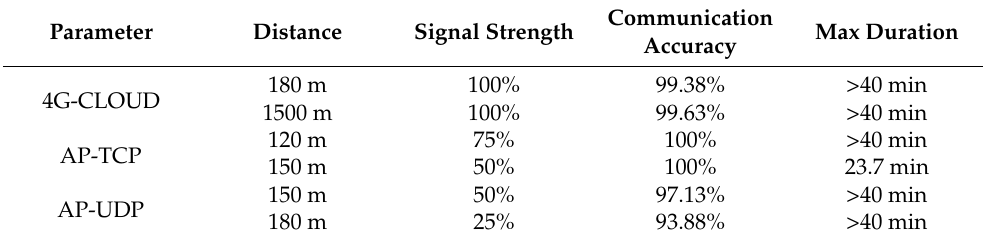
Table 3. Performance test results of three communication